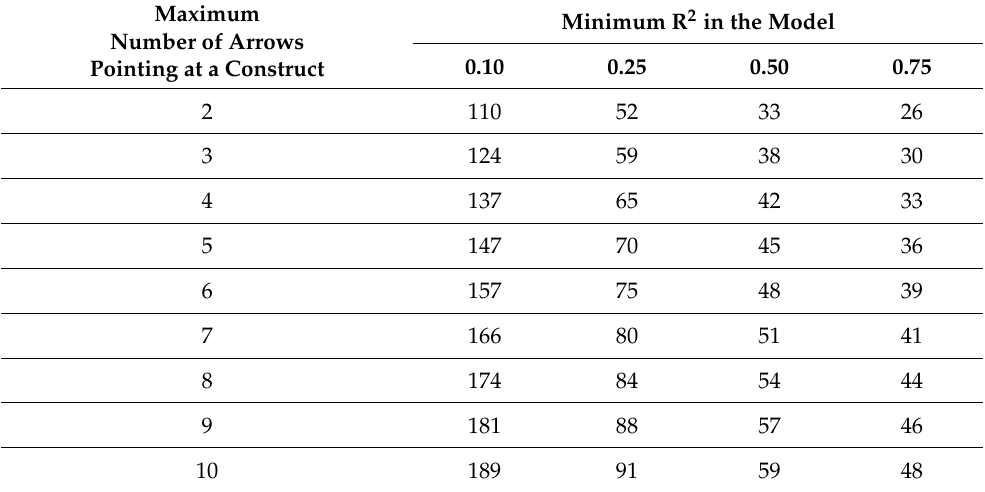
Minimum R 2 in the